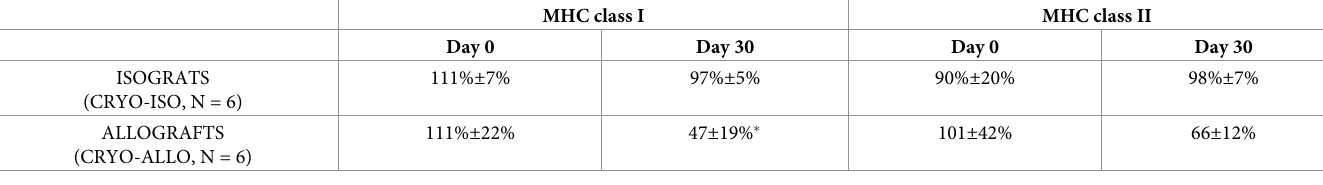
ISOGRATS (CRYO-ISO, N = 6) ALLOGRAFTS (CRYO-ALLO, N = 6)